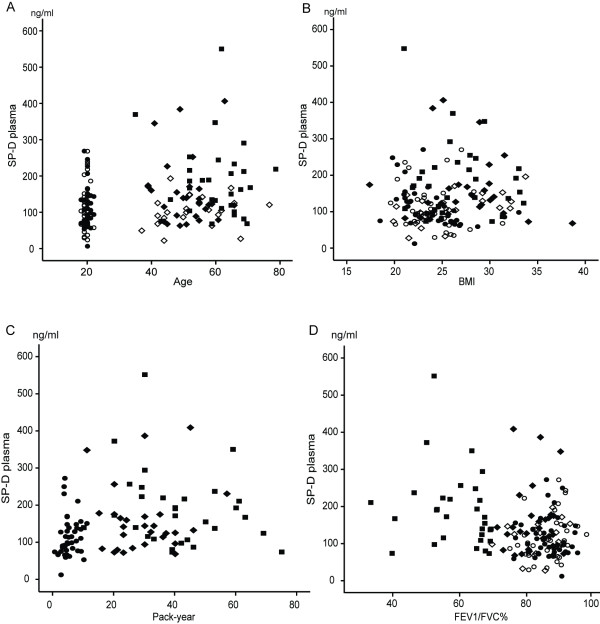
Relationship between plasma SP-D levels and the demographic parameters, age (A), BMI (B), pack-years (C) and FEV1/FVC% of predicted (D), in all of the subjects. ○ = young non-smokers; ● = young smokers; ◊ = middle aged/elderly non-smokers; ♦ = middle aged/elderly smokers; ■ = COPD patients.